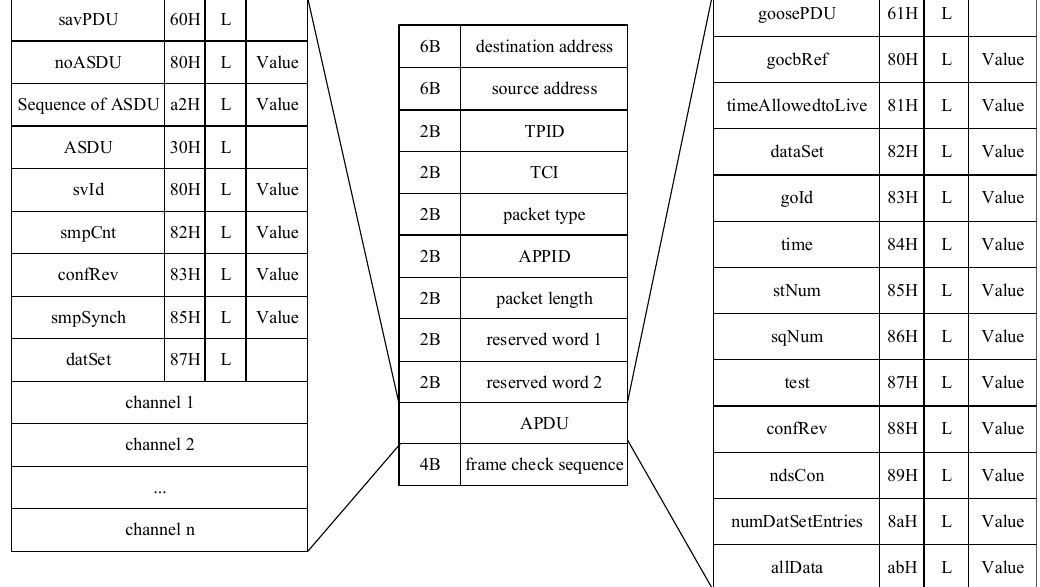
Figure 6. The frame structure of generic object oriented substation event (GOOSE) and sampled value (SV).